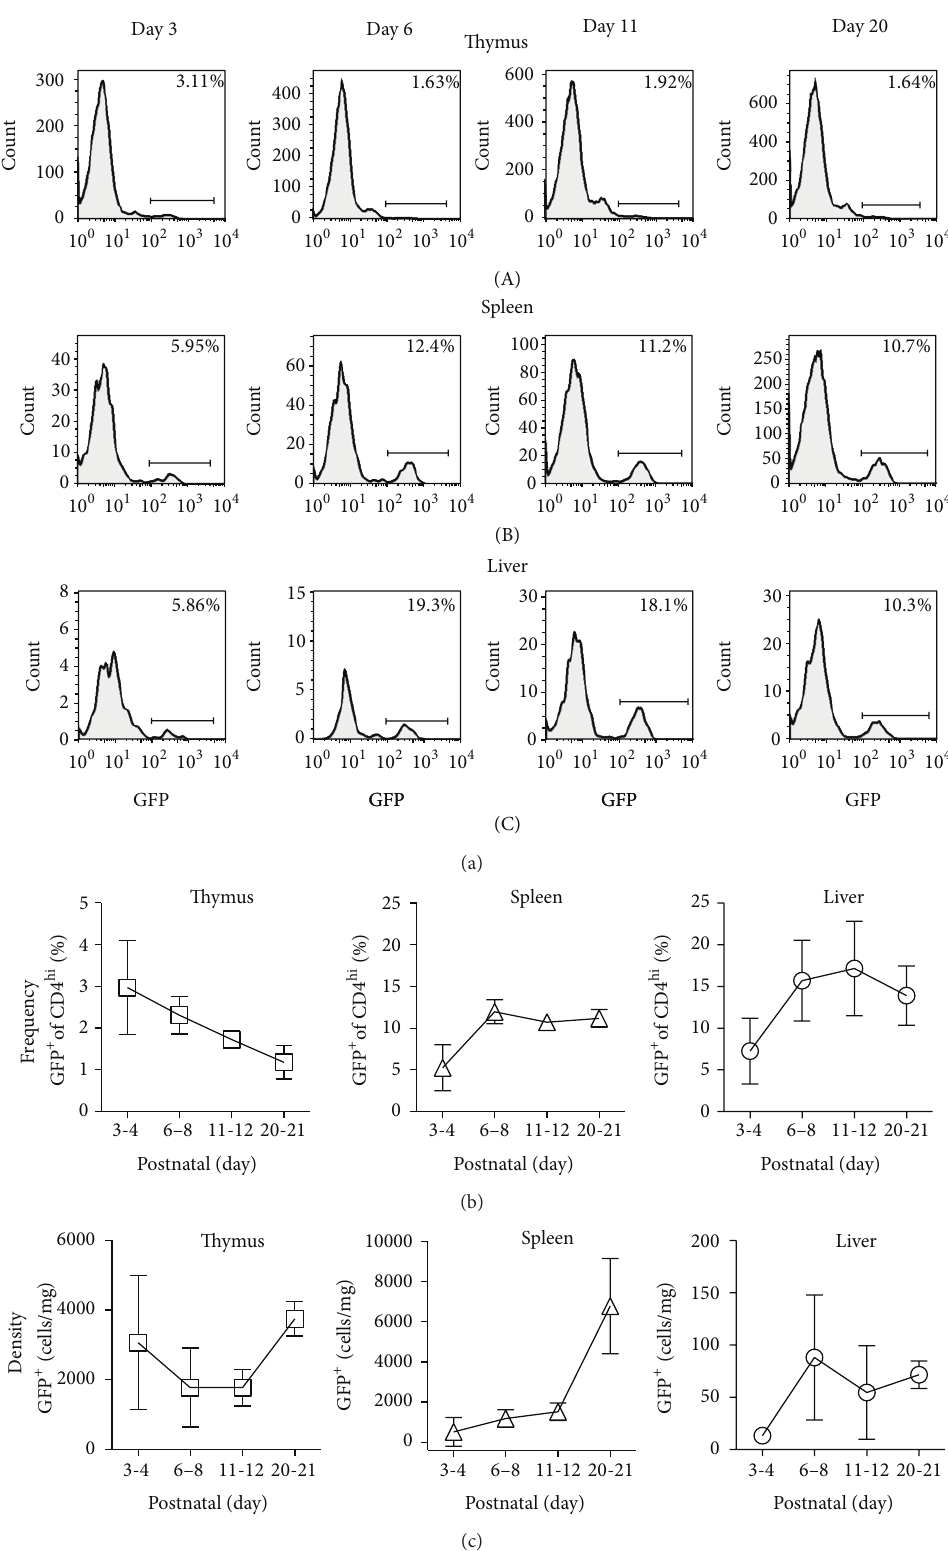
Figure 2: Postnatal development of FoxP3 + CD4 + cells in thymus, spleen, and liver. NPC were isolated from thymus, spleen, and liver of BALB/c-background FoxP 3 EGFP transgenic reporter mice of the indicated ages. (a) Individual GFP expression profiles of CD4 + T cells are shown. (b) Composite data from several mice are shown. Frequency indicates the percentage of CD4 + T cells that coexpress eGFP as a reporter of FoxP3 expression. 𝑁 = 3 to 8 mice per time point. (c) Composite data from several mice are shown. Density indicates the number of CD4 + eGFP + cells per wet weight of the organ. 𝑁 = 3 to 8 mice per time